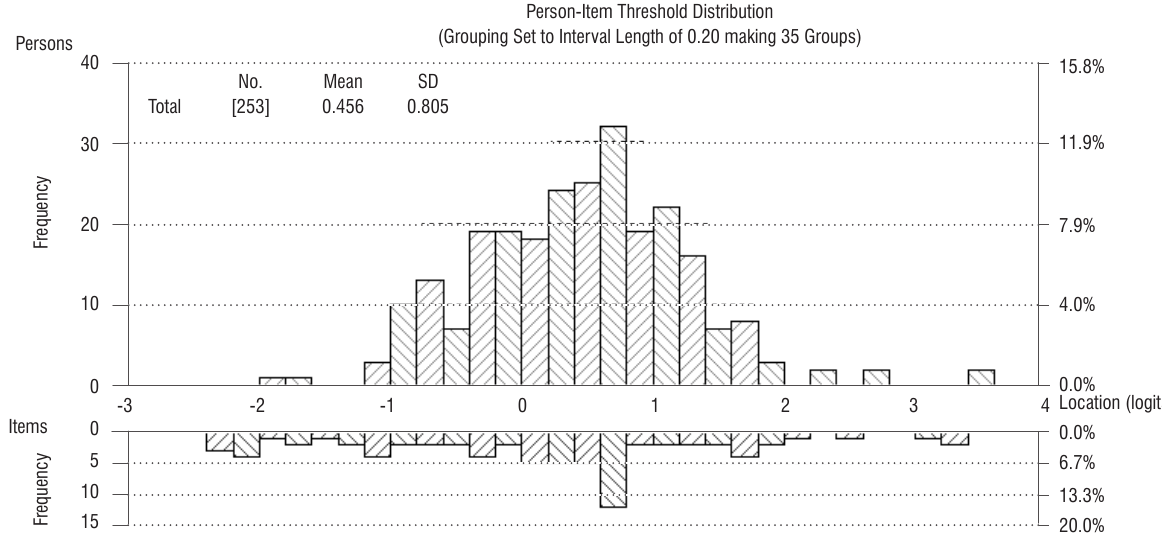
Person-Item Threshold Distribution (Grouping Set to Interval Length of 0.20 making 35 Groups)